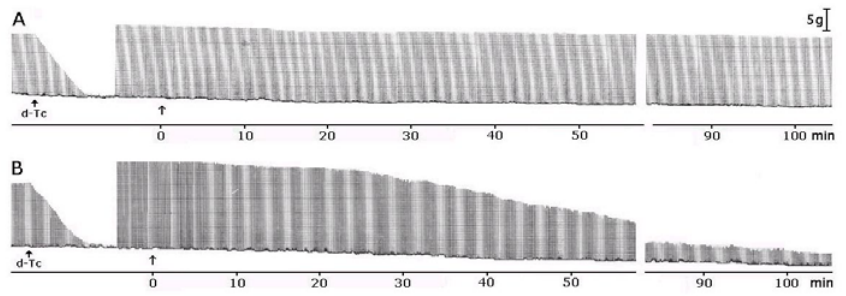
Figure 3. B. n. pauloensis venom effect on directly stimulated mouse phrenic nerve- diaphragm preparations. A and B show preparations treated with d -tubocurarine (7.3 µ M) before venom addition (20 µ g/ml and 50 µ g/ml, respectively, added at arrow) and directly stimulated diaphragm. Recordings are representative of 3-6